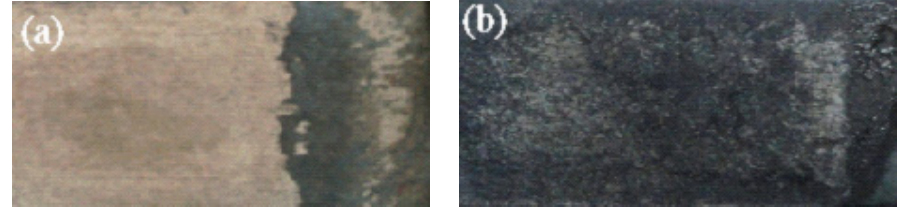
Figure 7. Morphology of failed surface of ( a ) HA-CNT and ( b ) HA-CNT/TiO the coatings peeled off from the substrate after adhesion